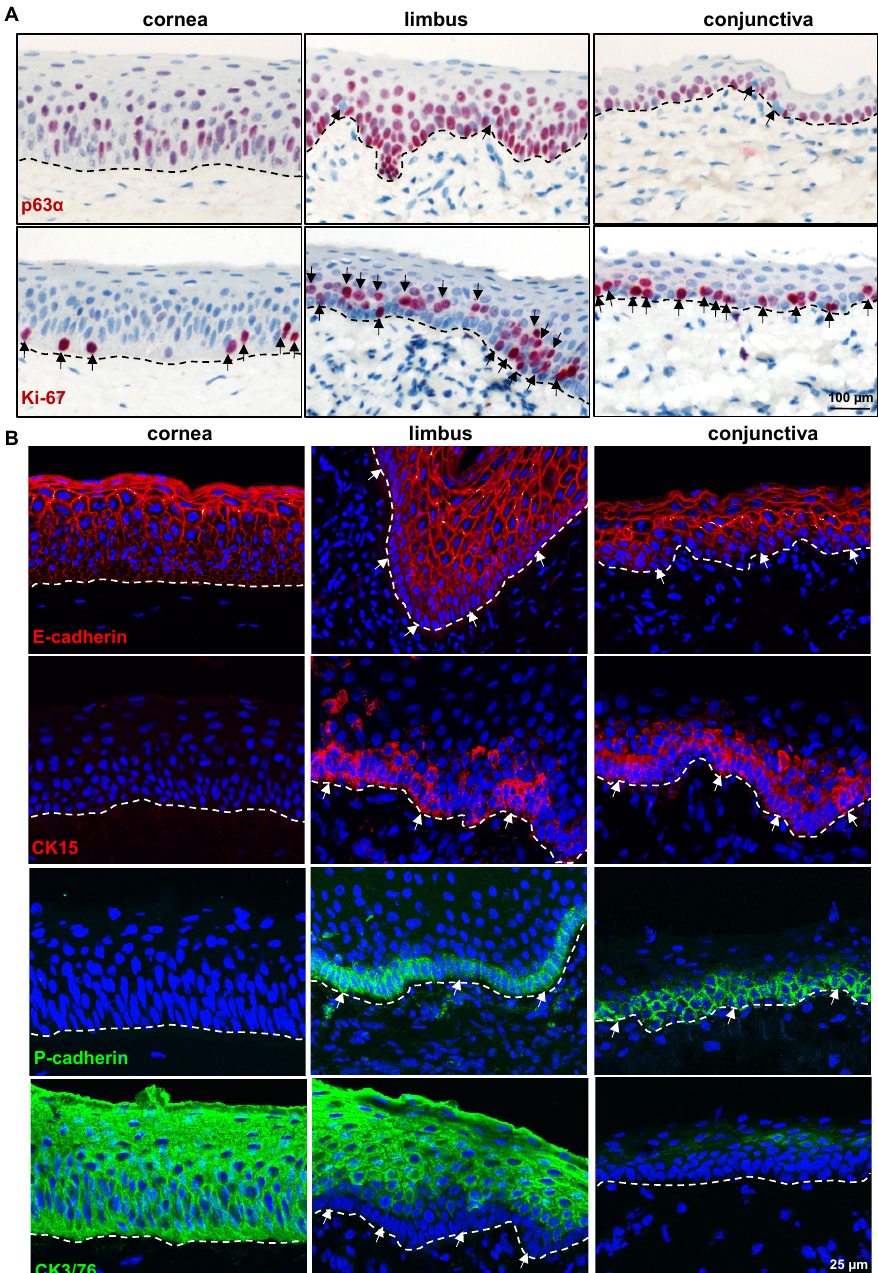
Figure 3. Expression analysis of epithelial-related markers: ( A ) Immunostaining of corneoconjunctival tissue showing the expression of p63α in the basal layers of corneal, limbal, and conjunctival epithelia, but the stronger expression in the limbus and conjunctiva and a few negative cells in the limbal and conjunctival basal layers (arrows); Ki-67 expression in the basal cells of the cornea, limbus, and conjunctiva (arrows); dashed line represents basement membrane (BM). ( B ) Immunofluorescence staining of frozen sections showing the expression of E-cadherin in the superficial layers of epithelial cells in both limbus and conjunctiva (red), leaving the basal cells negative (arrows), whereas all layers of corneal epithelium expressed E-cadherin; CK15 expression in the basal layers of the limbal and conjunctival epithelia (arrows, red) but not in the corneal epithelia; P-cadherin expression in the basal layers of limbal and conjunctival epithelia (arrows, green); CK3/76 expression (green) in all layers of the corneal epithelium and in suprabasal cell layers of limbal epithelium but not in basal layers (arrows); nuclear counterstaining with 4 (cid:48) ,6-diamidino-2-phenylindole (blue); dashed line represents